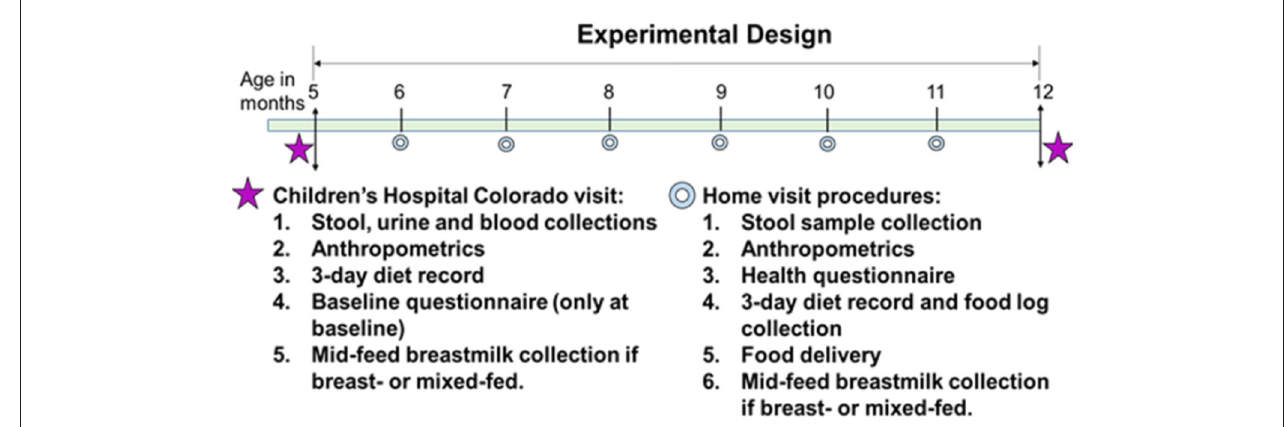
FIGURE 1 | Experimental